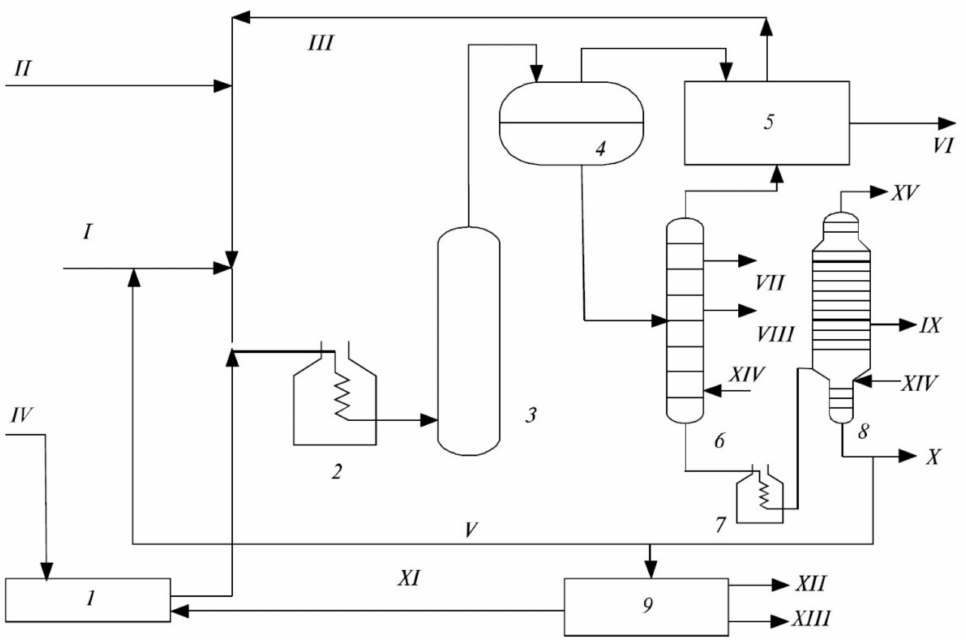
Figure 5. Schematic view of the oil-residue hydroconversion unit. 1—catalyst preparation unit; 2, 7—furnaces; 3—reactor; 4—separator unit; 5—gas treatment unit; 6—distillation column; 8—vacuum column; 9—catalyst regeneration unit; I—stock; II—hydrogen; III—hydrogen-containing gas; IV—aqueous solution of fresh catalyst; V—recycle; VI—gas; VII—naphtha; VIII—diesel fraction; IX—heavy gas oil; X—residue; XI—regenerating catalyst; XII—chemical fertilizer; XIII—ash (nickel and vanadium); XIV—water vapor; XV—vacuum